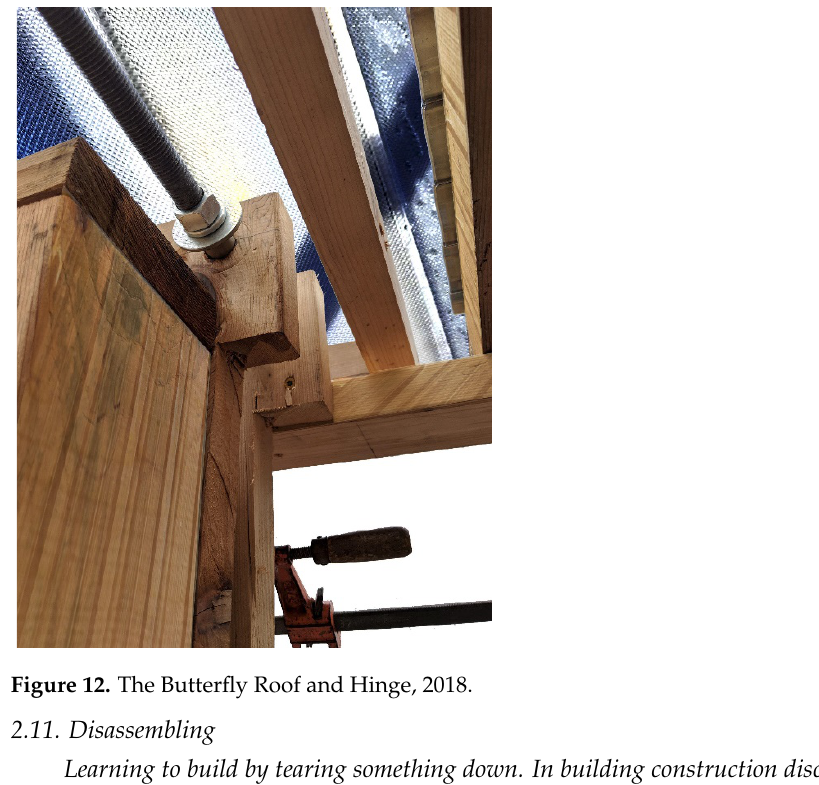
Figure 11. Repurposing Slide by Lissandra Hadron Dyer (2018).